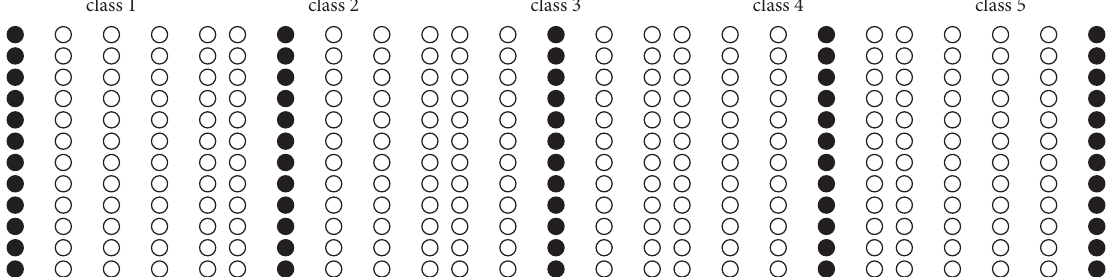
Figure 5: Equilibrium point